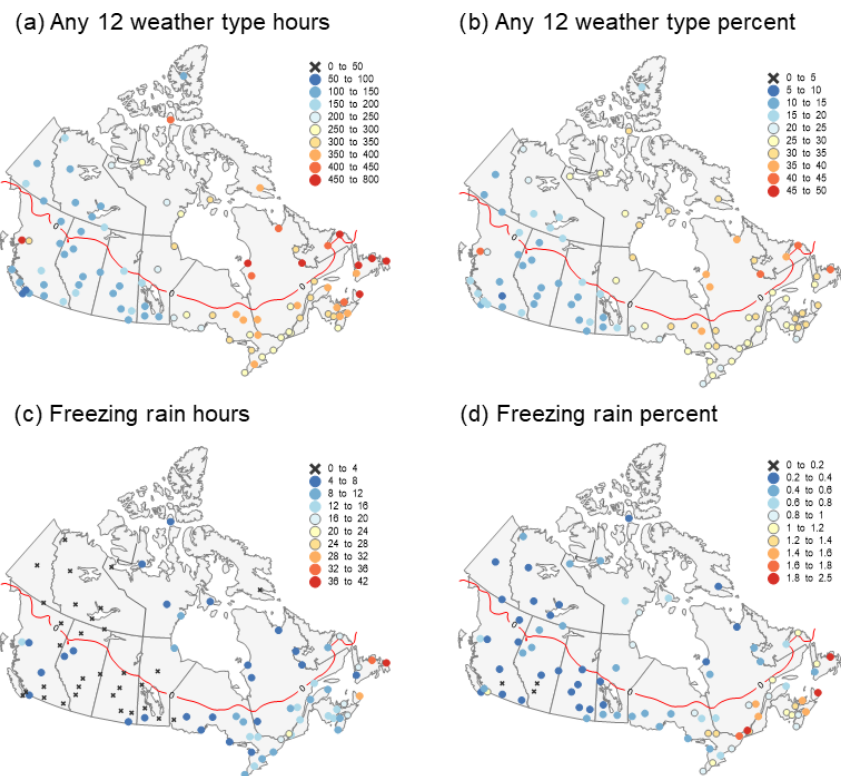
Figure 4. Precipitation type occurrences during near-0 ◦ C ( − 2 ≤ T ≤ 2 ◦ C) conditions over the 1981–2011 period: (a) average annual num- ber of hours with reported precipitation types (any of the 12), (b) percentage of near-0 ◦ C conditions associated with reported precipitation types (any of the 12), (c) average annual number of hours with freezing rain, and (d) percentage of near-0 ◦ C conditions associated with freezing rain. The red line indicates the annual average 0 ◦ C surface temperature computed from the 1981 to 2010 climate normals (ECCC,